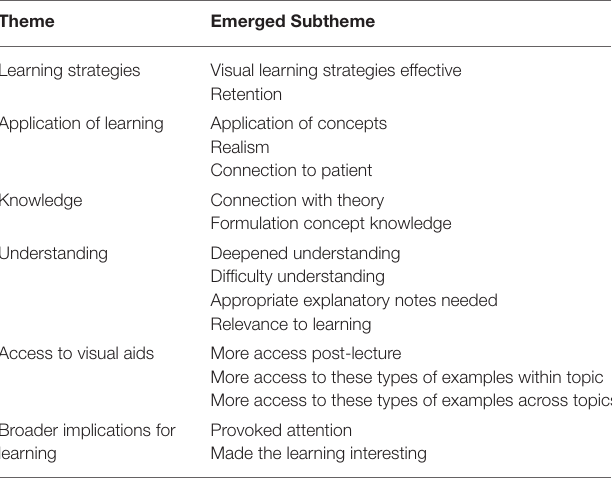
TABLE 6 | Themes and subthemes emerged from the free text